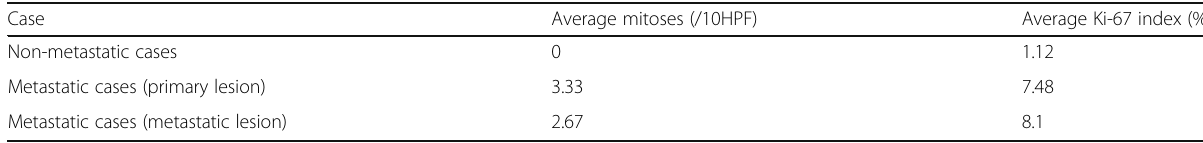
Table 4 Comparison of proliferative indices between non-metastatic & metastatic cases